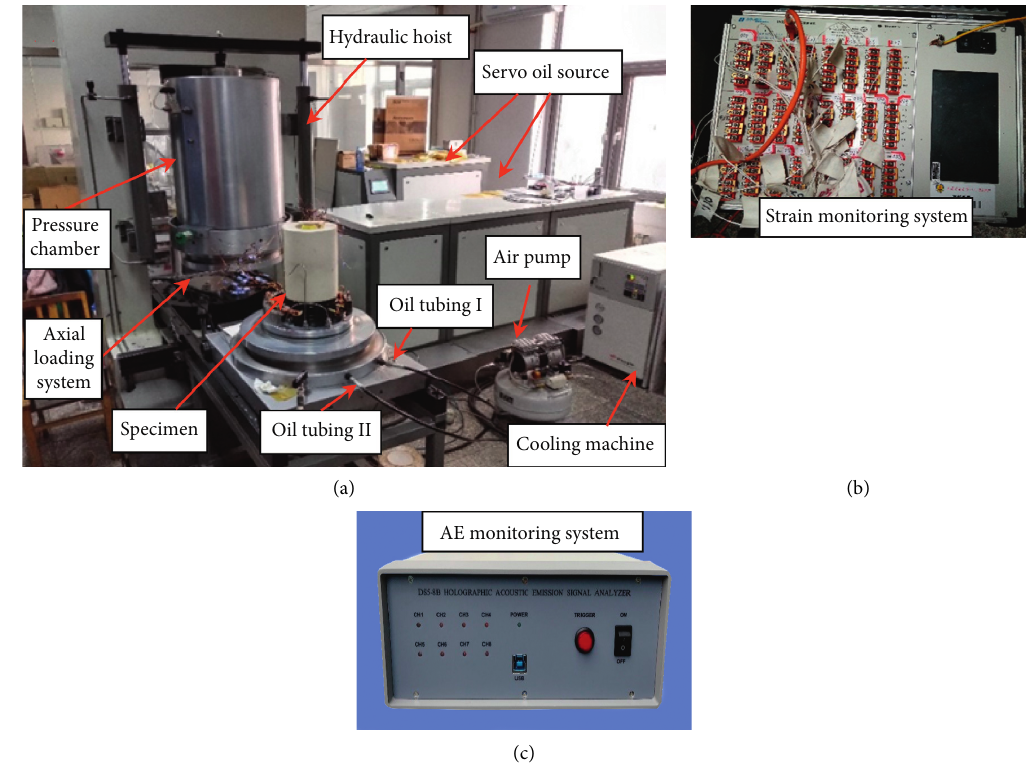
Figure 1: Illustration of the tunnel excavation unloading test system: (a) the unloading test machine; (b) the strain monitoring system; (c) the AE monitoring system.